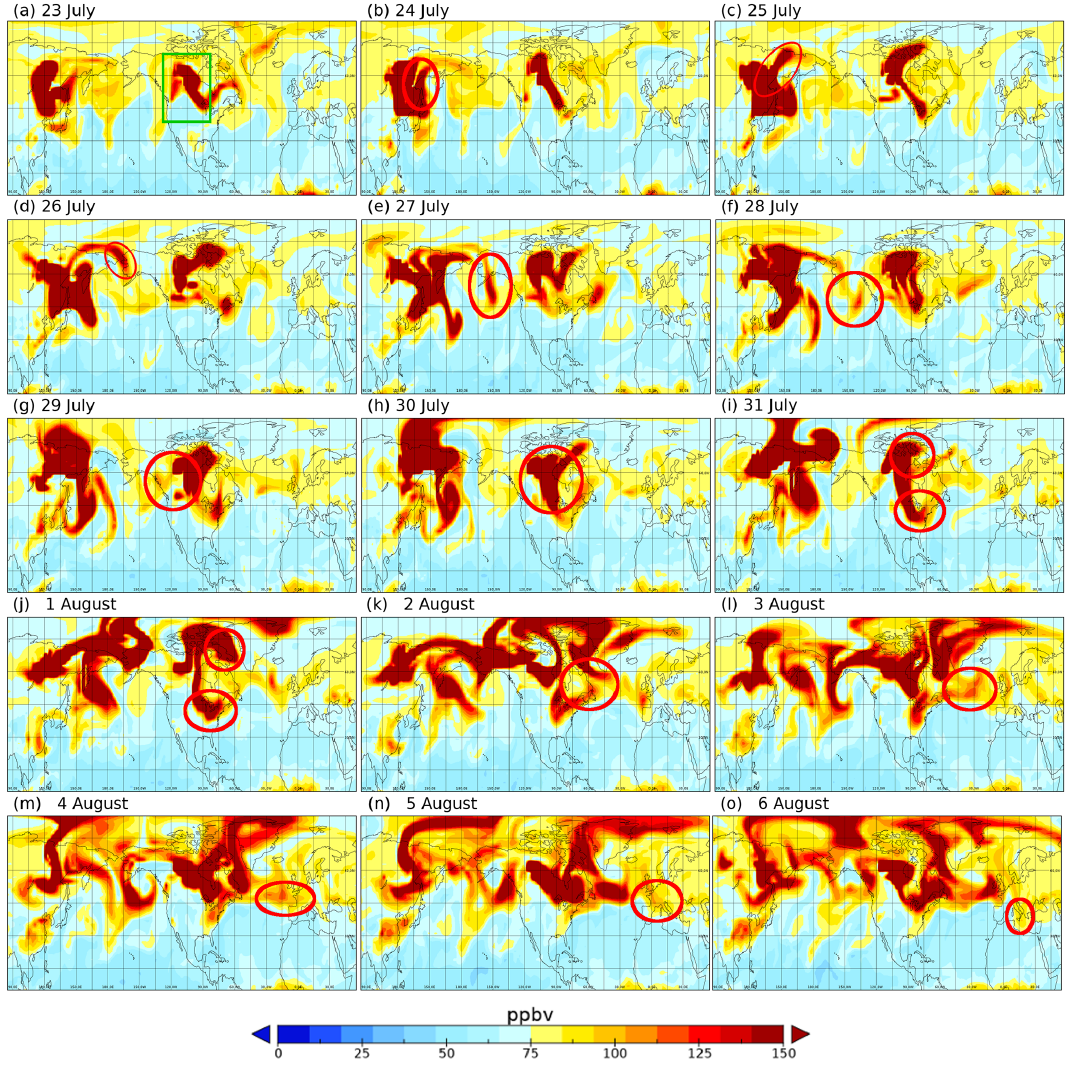
Figure 7. CO concentrations at 12:00UTC between 23 July and 6 August 2014 at 5.5km in altitude simulated by the MOCAGE model. The red ellipses are used to follow the biomass burning trace in CO along the trajectory. The green square in panel (a) corresponds to the box used for Fig.